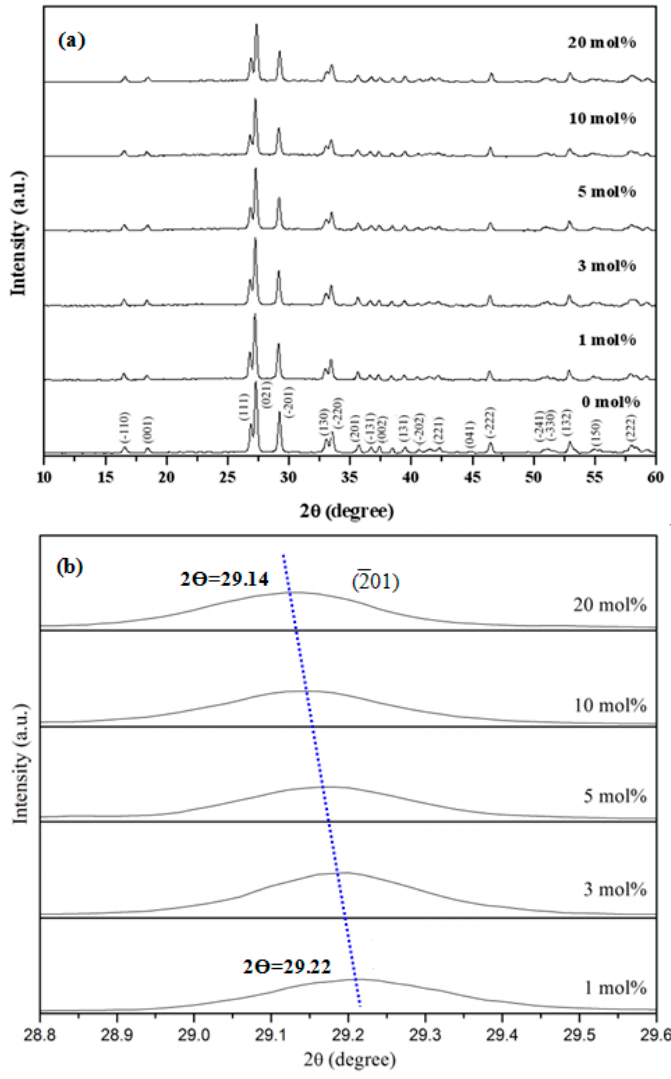
Figure 1. ( a ) X-ray diffraction patterns of YInGe 2 O 7 doped with different Sm 3+ ion concentrations calcined at 1300 °C for 10 h in air; ( b ) The peak position of (201) diffraction plane as a function of Sm 3+ ion concentration.